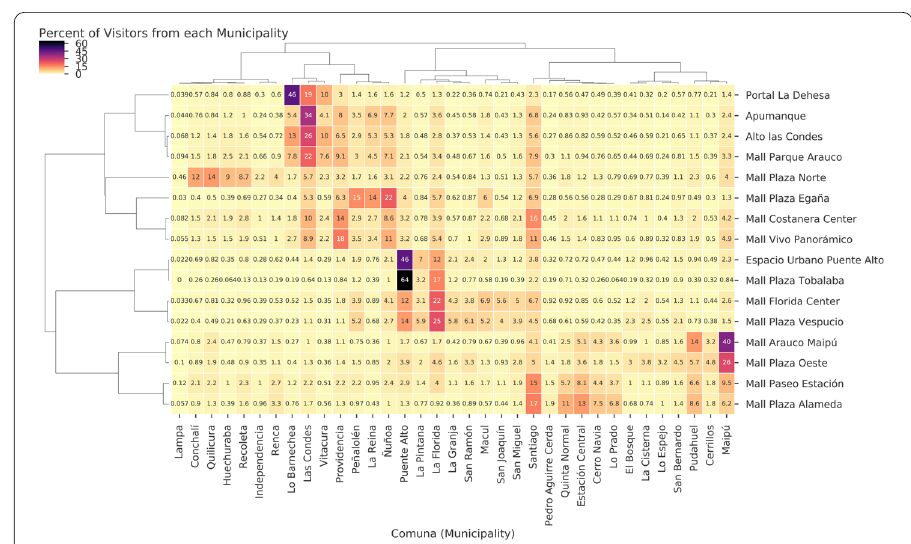
Figure 3 Heatmap of mall visitors according to their comuna of residence. The matrix is row-normalized, meaning that each row encodes the percent of mall visitors from each comuna . Note that even though the city is named Santiago, the center comuna is also named Santiago